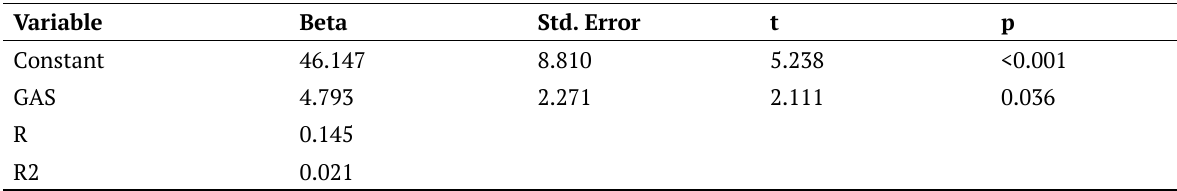
Table 4. Simple Linear Regression Analysis (Model 1)